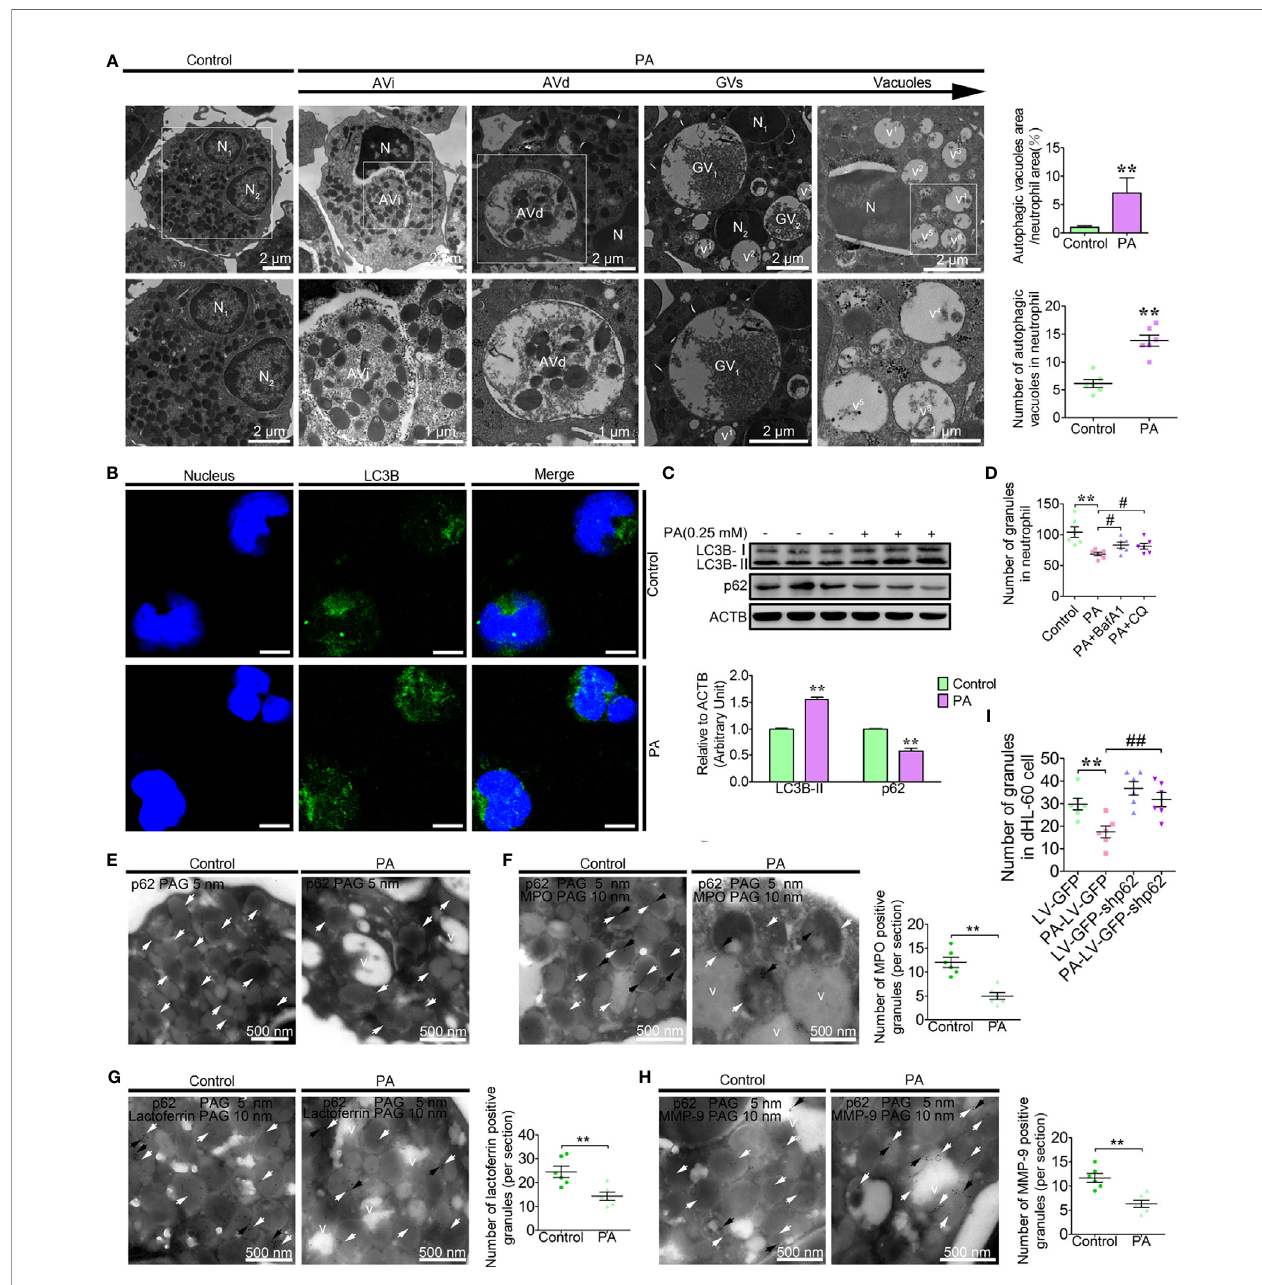
FIGURE 2 | PA triggers autophagy-dependent degradation of the granules and vacuolation in dairy cow neutrophils. (A) Representative transmission electron micrographs of control and PA (0.25 mM)-treated neutrophils (left). White arrows indicate autophagic vacuoles (AVi, AVd, glycogen vacuoles, and vacuoles). N (N1, N2, N3 … ), nucleus. Scale bars as indicated. The area ratio of autophagic vacuoles to neutrophils and the number of autophagic vacuoles in neutrophils were determined (right, n = 6). Data represent the mean ± s.e.m. (** p < 0.01 versus the control group; signi fi cance calculated using t -test). (B) Autophagy levels were evaluated using confocal microscopy in control and PA-treated neutrophils. Neutrophils were stained with anti-LC3B antibody and nuclear DNA was stained with Hoechst 33258. Scale bar, 5 m m. (C) Immunoblot for LC3B and p62 in control and PA-treated bovine neutrophils. ACTB was used as a loading control ( n = 3). Data represent the mean ± s.e.m. (** p < 0.01 versus the control group; signi fi cance calculated using two-way ANOVA). (D) The number of granules in PA-treated neutrophils (autophagy pathway was blocked using BafA1, CQ or not, n = 6). Data represent the mean ± s.e.m. (** p < 0.01 versus the control group, # < 0.05 and versus the PA-treated group; Signi fi cance calculated using one-way ANOVA). (E) Immunogold electron micrograph showing the localization of p62 in control and PA- treated bovine neutrophils. (F) P62-mediated PA-triggered autophagy-dependent degradation of AGs, SGs, and GGs in bovine neutrophils. Partial view of immunogold electron micrograph showing the colocalization of p62 with the AG marker MPO (F) , SG marker lactoferrin (G) , and GG marker MMP-9 (H) in control and PA-treated BPMNs. White arrows (5-nm gold grains) indicate p62. Black arrows (10-nm gold grains) indicate MPO, lactoferrin, and MMP-9. v (v1, v2, v3 … ), vacuoles. (I) The number of granules in control and PA-treated dHL-60 cells (infected with LV-GFP-shp62) was determined ( n = 6). Data represent the mean ± s.e.m. (** p < 0.01 versus the control group, ## p < 0.01 and versus the PA-treated group; signi fi cance calculated using one-way